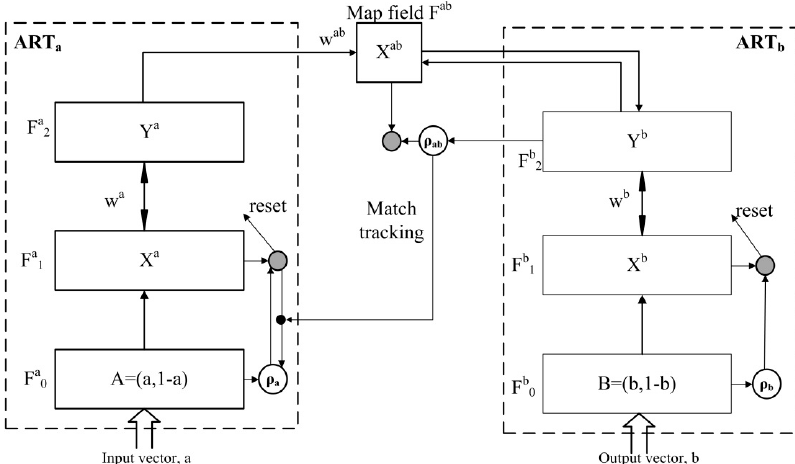
Figure 4. Fuzzy ARTMAP structure, a is the input vector (features obtained from the sensors’ response) and b is corresponding class to measurement described by input vector a (during training or calibration). For more information about other parameters, the reader is referred to the cited literature [27,45].